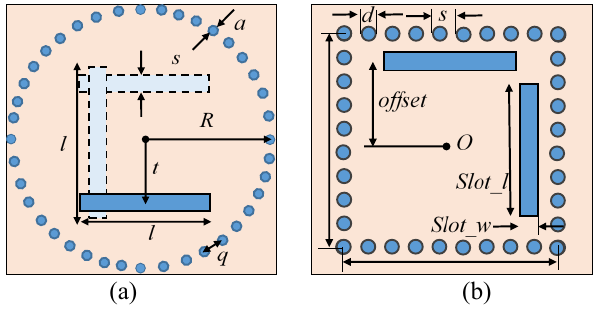
Figure 12. Unit cell topology of Polarization rotators. (a) Transmission type [40]. (b) Reflective type [39].